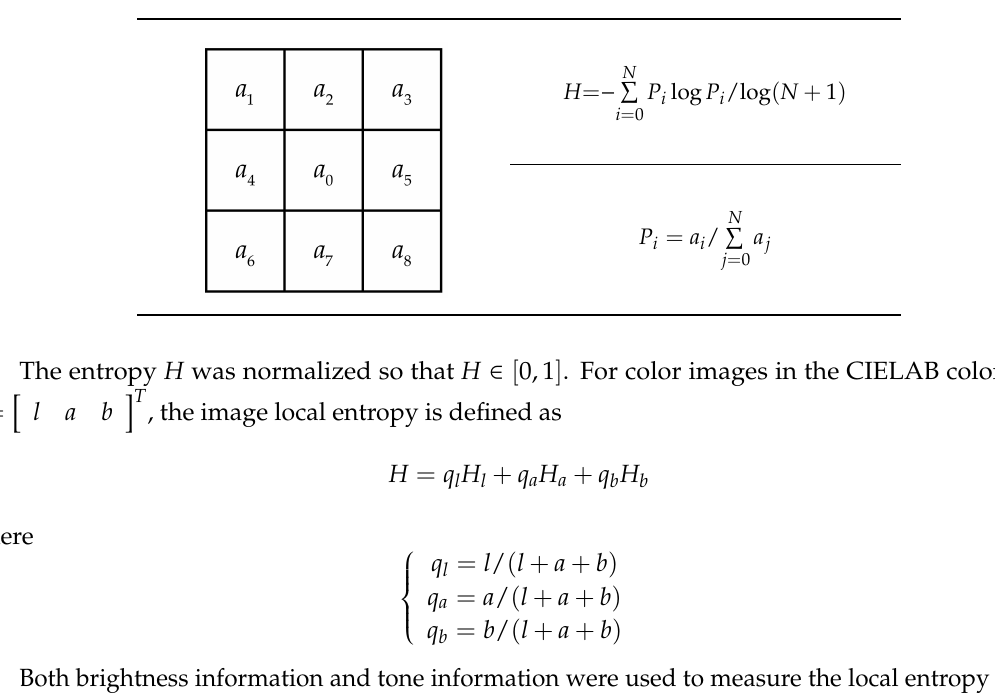
Table 1. Entropy